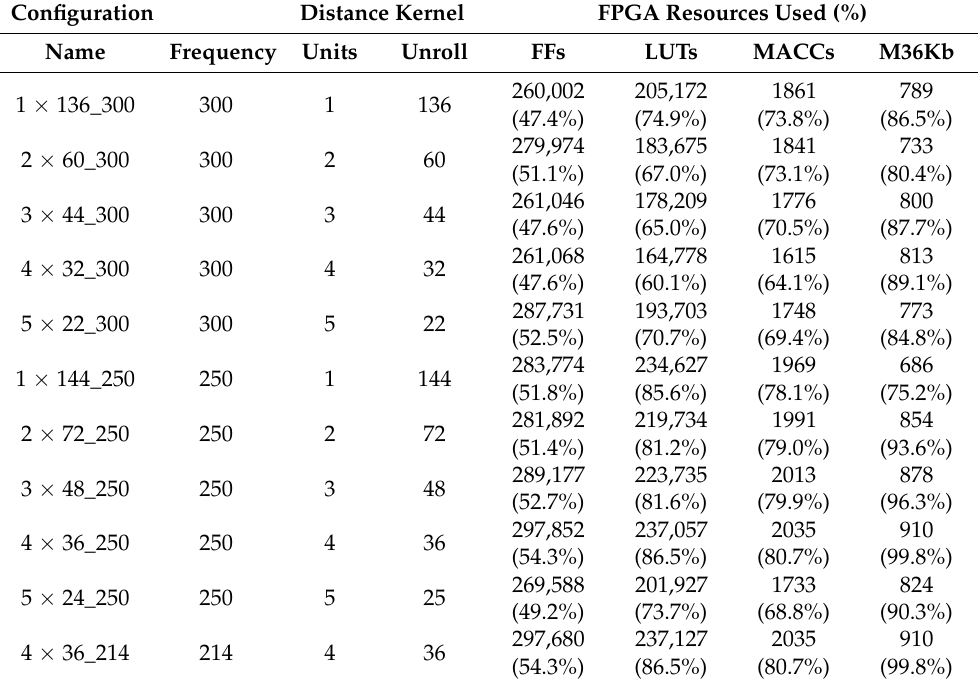
Table 3. Characteristics of different configurations tested in the Xilinx FPGA.